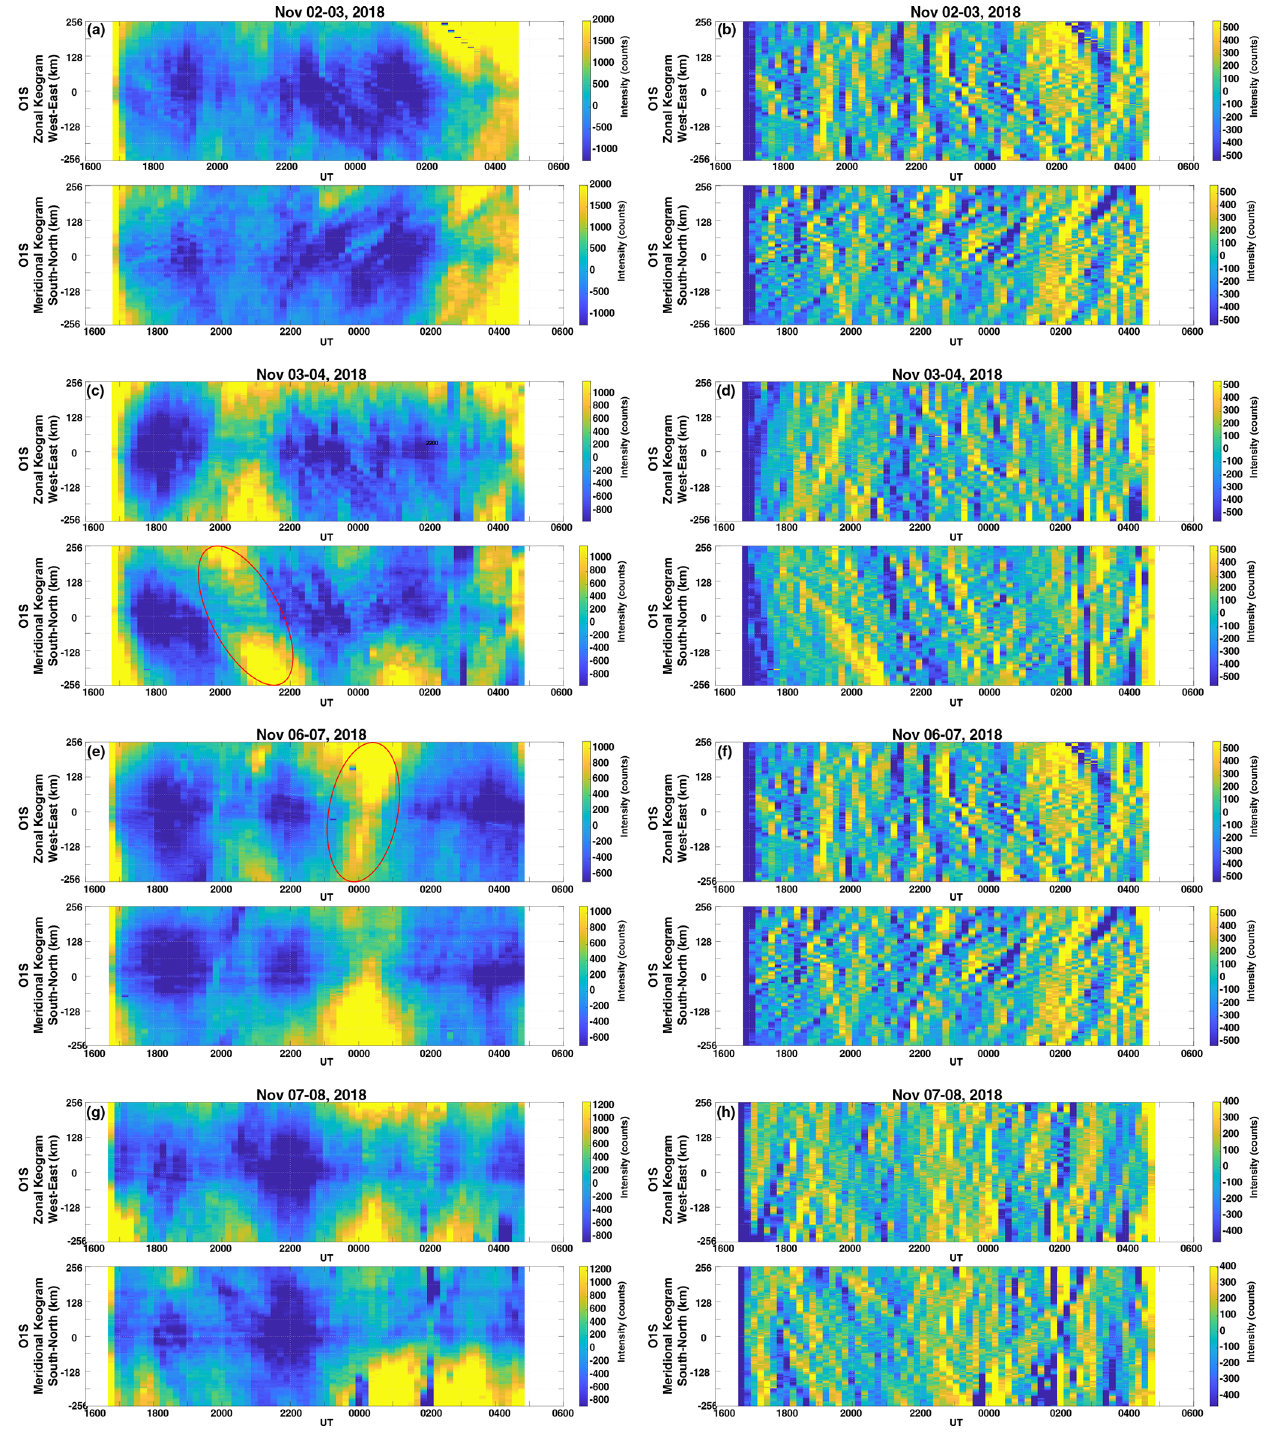
Figure 1. Composite keograms of O( 1 S) airglow images taken on clear nights during the SIMONe–2018 campaign. The keograms in panels (a) , (c) , (e) , and (g) were built using light frame images, while keograms in panels (b) , (d) , (f) , and (h) were built using TD images. Time–difference keograms show short-period waves at higher contrast, while light frame keograms show mainly long-period oscillations. Note the enhanced airglow brightness (red ellipses) on 3–4 November (meridional keogram) and 6–7 November (zonal keogram) associated with large-scale gravity waves also seen in wind fluctuations of Fig.